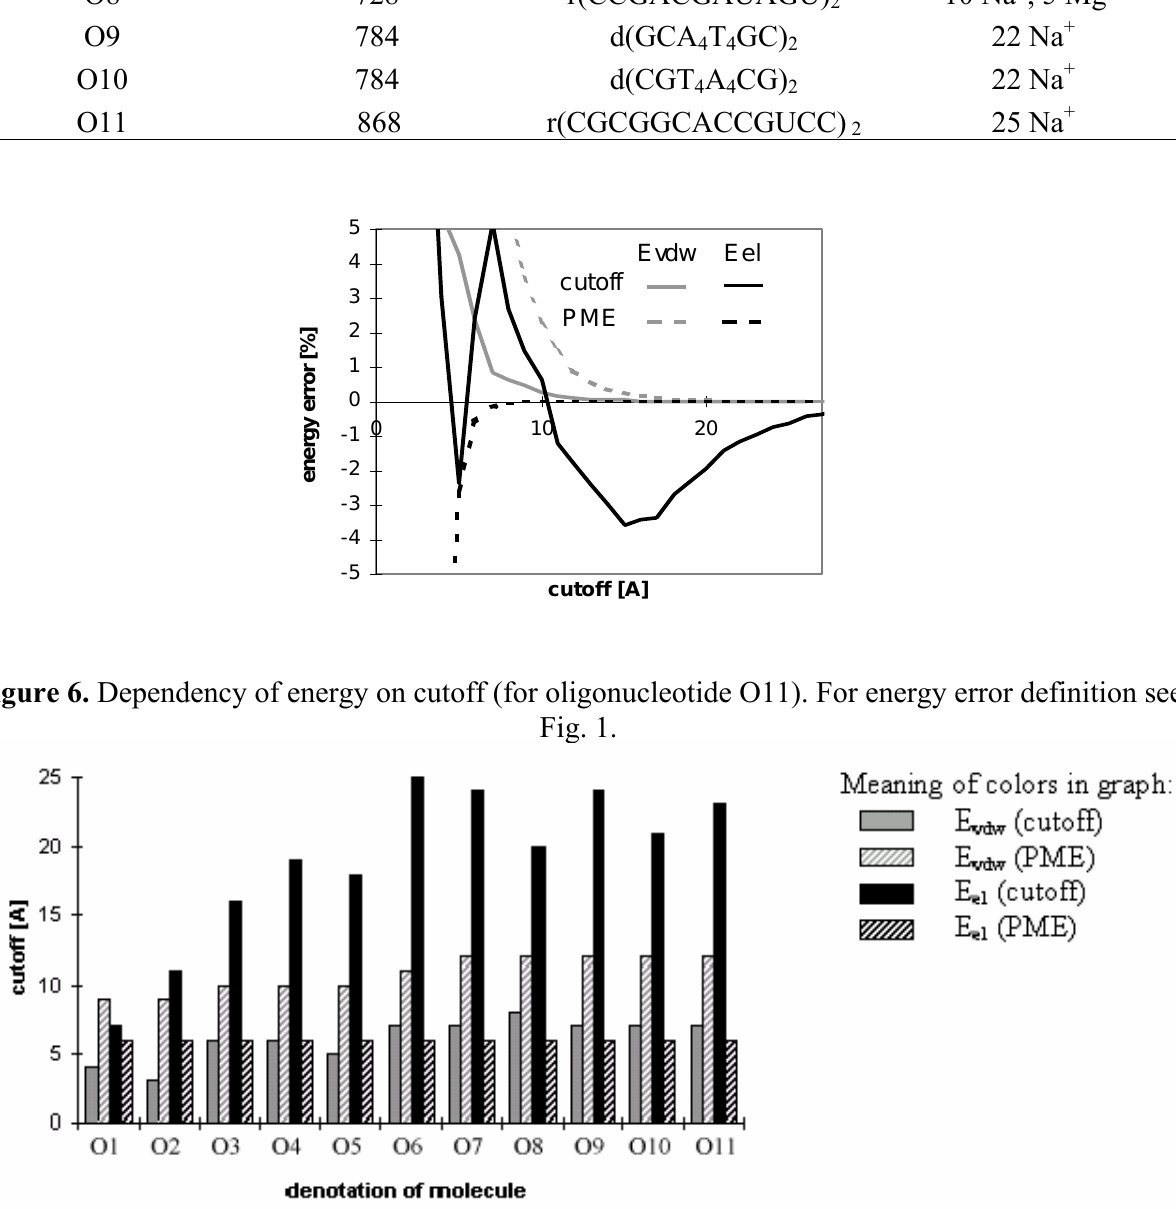
Figure 7. Smallest values of cutoff for which energy error is smaller then 1% (for